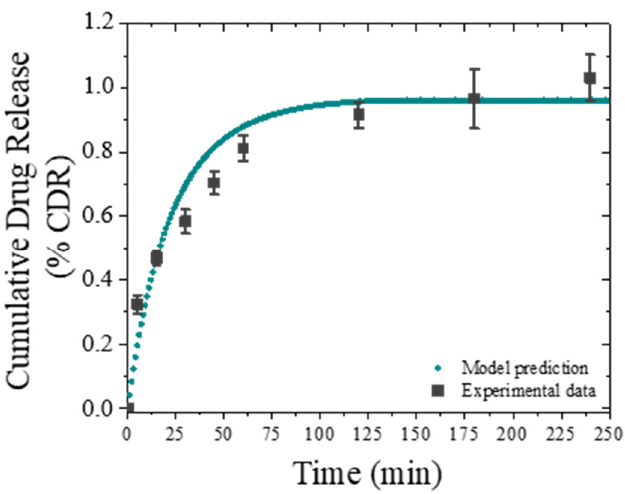
Figure 6. Cumulative Drug Release: Drug release versus time in PBS and the model prediction after parameter estimation (blue line); (mean ± SD, n = 3).